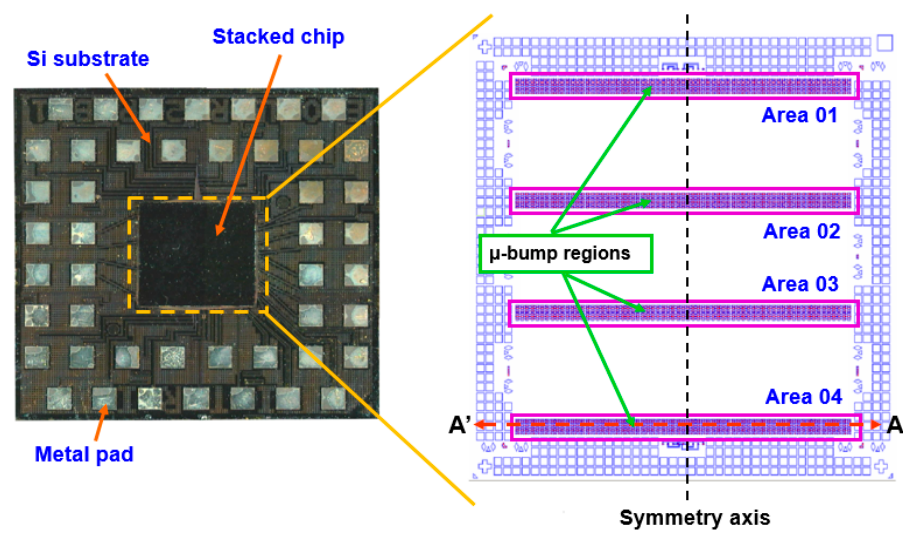
Figure 1. Small stacked chips mounted at the center of a large Si substrate using FC technology and the water level underfill (WLUF) process.